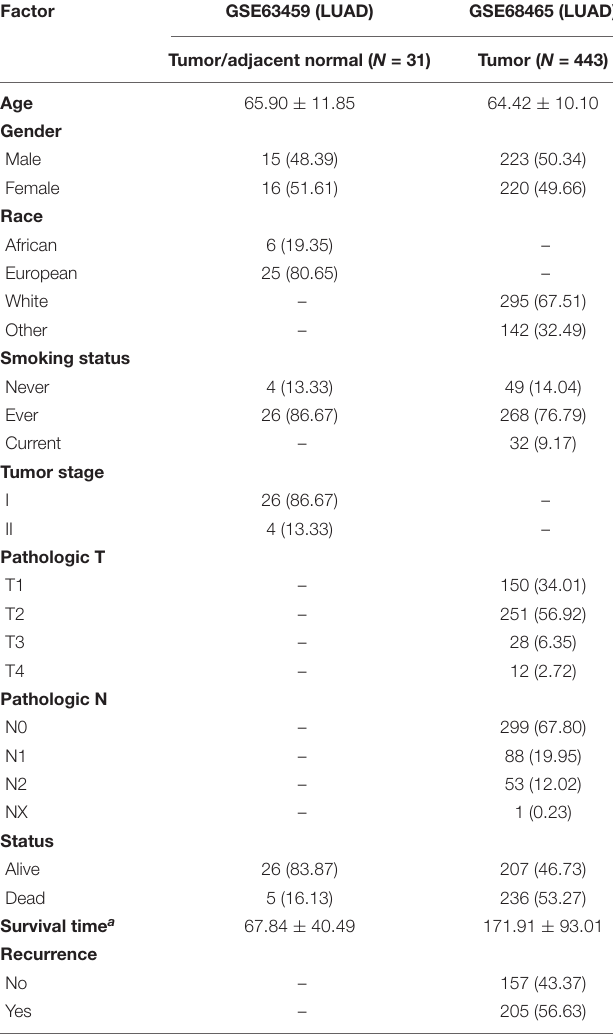
TABLE 2 | Baseline of dataset GSE63459 and